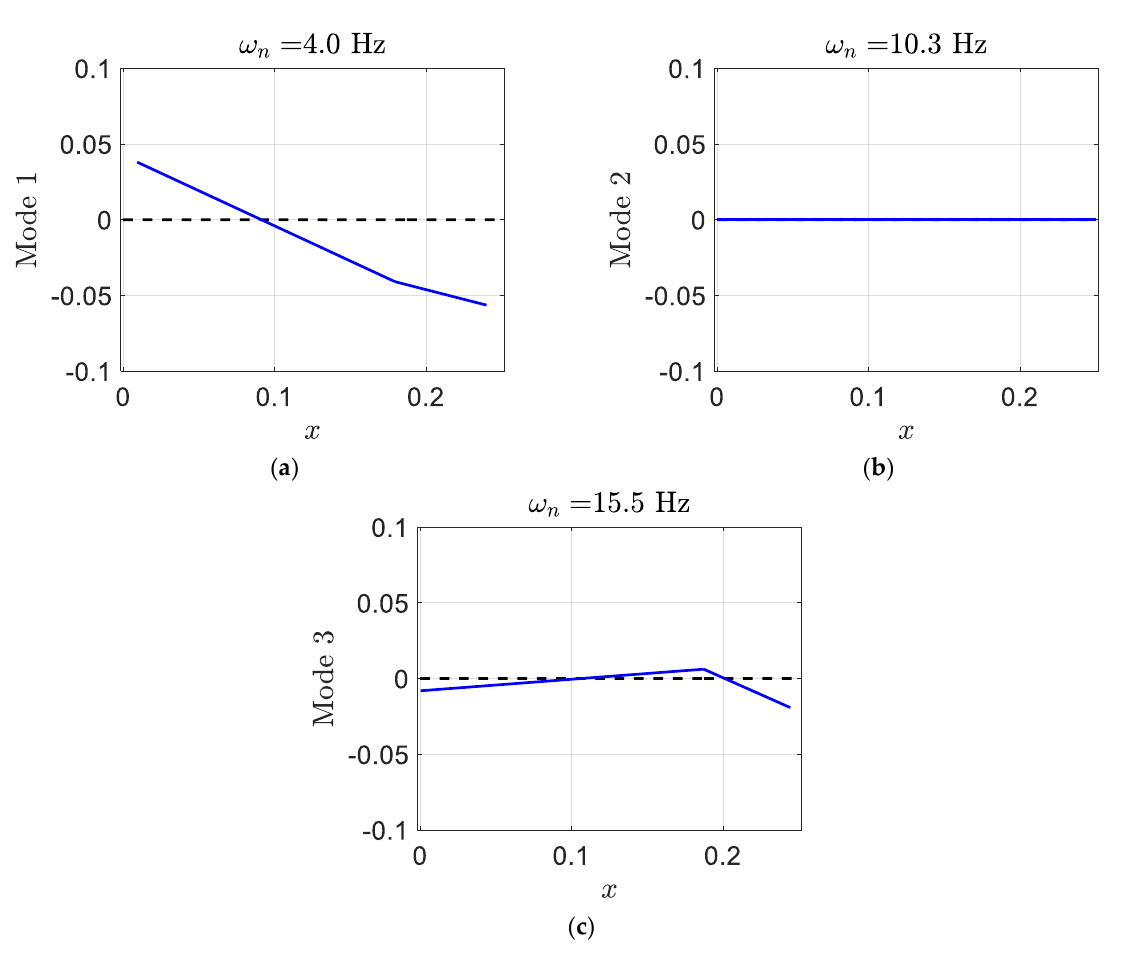
Figure 14. The smart blade unsteady plunge − pitch − control mode shapes at U = 74.2973 m/s: ( a ) ω n = 4.0 Hz; ( b ) ω n = 10.2 Hz; ( c ) ω n = 15.5 Hz .